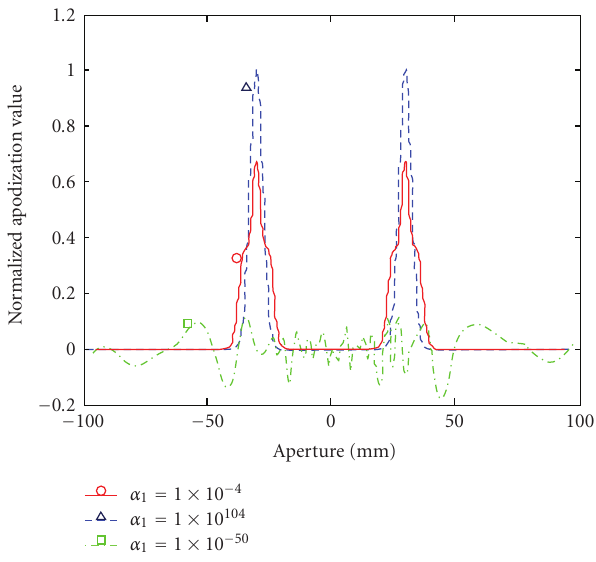
Figure 4: Apodization functions obtained for σ y = 0.8 mm with a regularized WMNLS estimation using di ff erent regularization parameter α 1 values: 1 × 10 − 50 (dash-dot line with square, unstable), 1 × 10 − 4 (solid line with circle, corresponding to the stable apodization function shown in Figure 1(a)), and 1 × 10 104 (dashed line with triangle, the same as that obtained with a Fraunhofer approximation shown in Figure